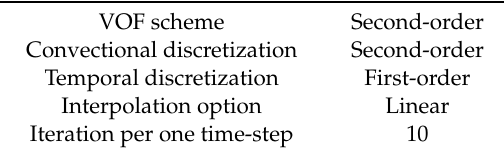
Table 2. Features of the Physical